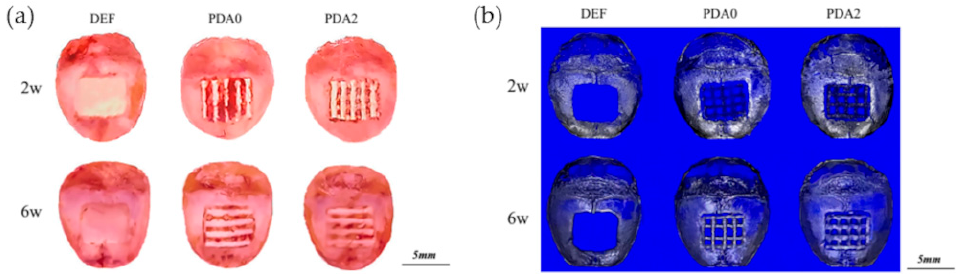
Figure 16. Gross specimens ( a ) and micro-CT-reconstructed images ( b ) of experimental animals at 2 weeks and 6 weeks after bare or PDA-coated scaffold-implantation surgery. Reproduced with permission from [144]. Copyright Multidisciplinary Digital Publishing Institute (MDPI), 2019.